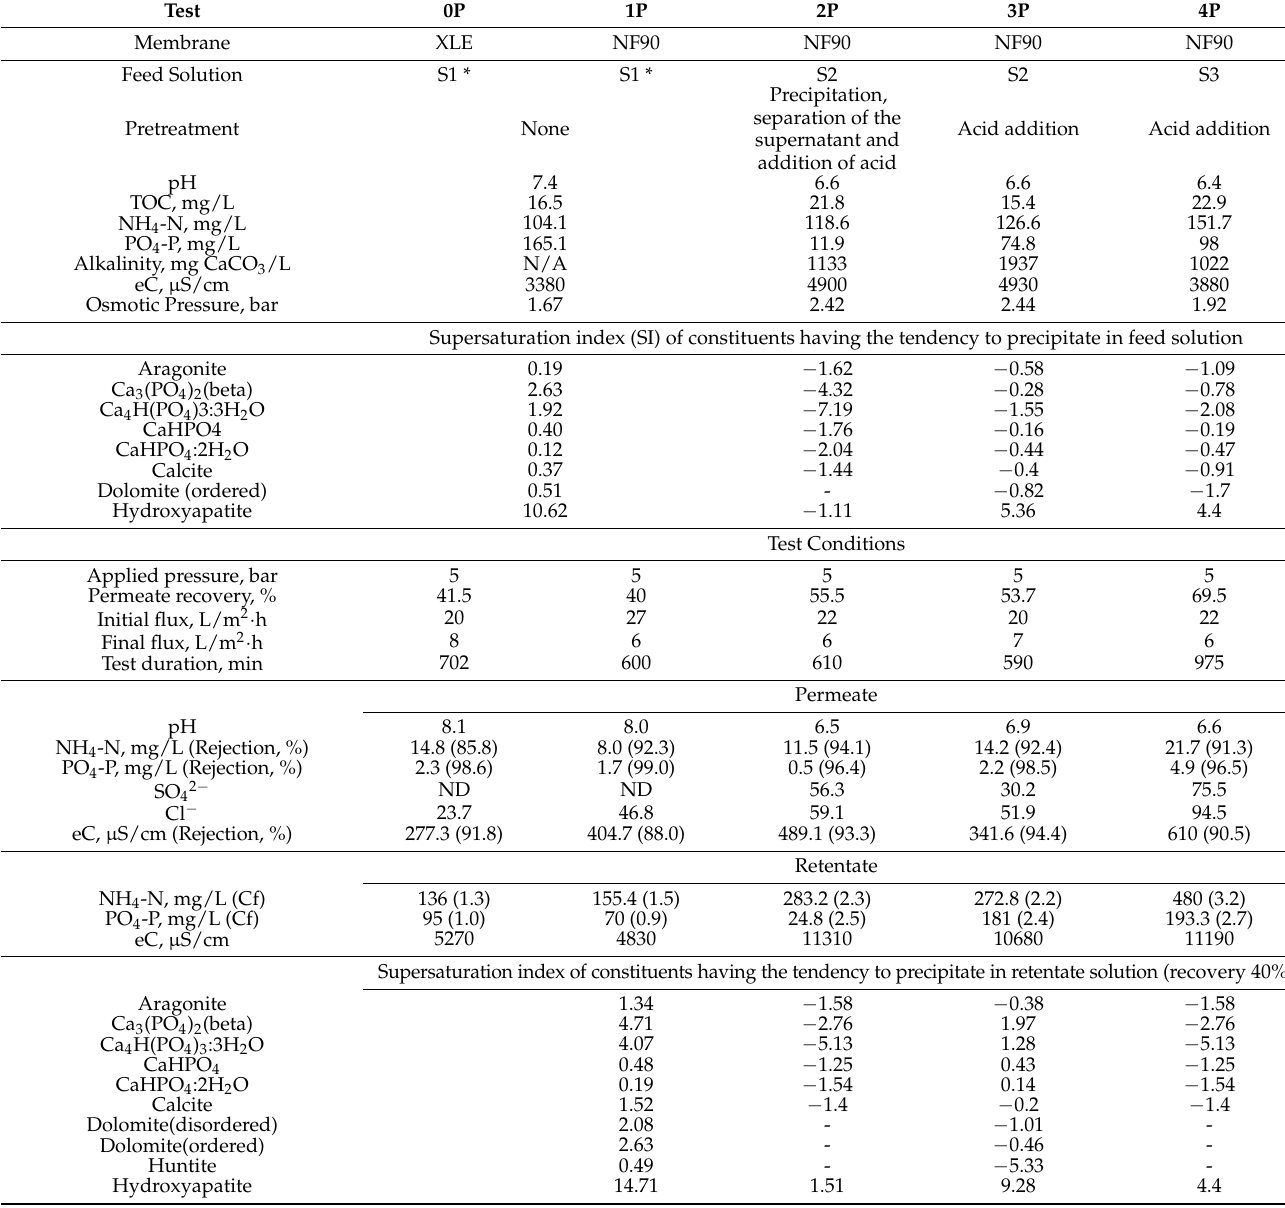
Table A3. Main physicochemical parameters of feed solutions, conditions, and key